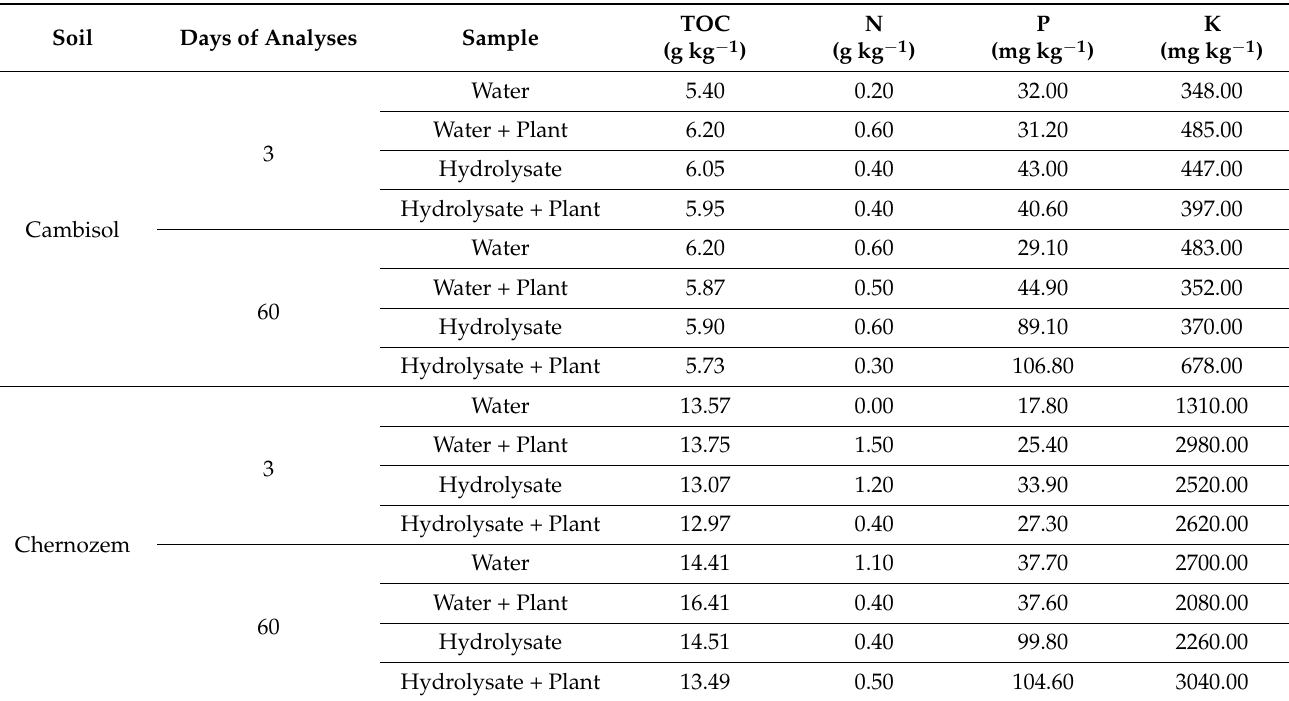
Table 4. Content of total organic carbon (TOC) and N, P, K concentration in two types of soil in different experimental